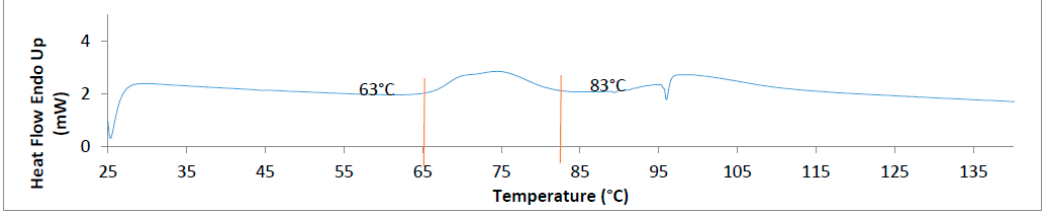
Figure 4. Result of differential scanning calorimetry (DSC) analyses of gelatin.